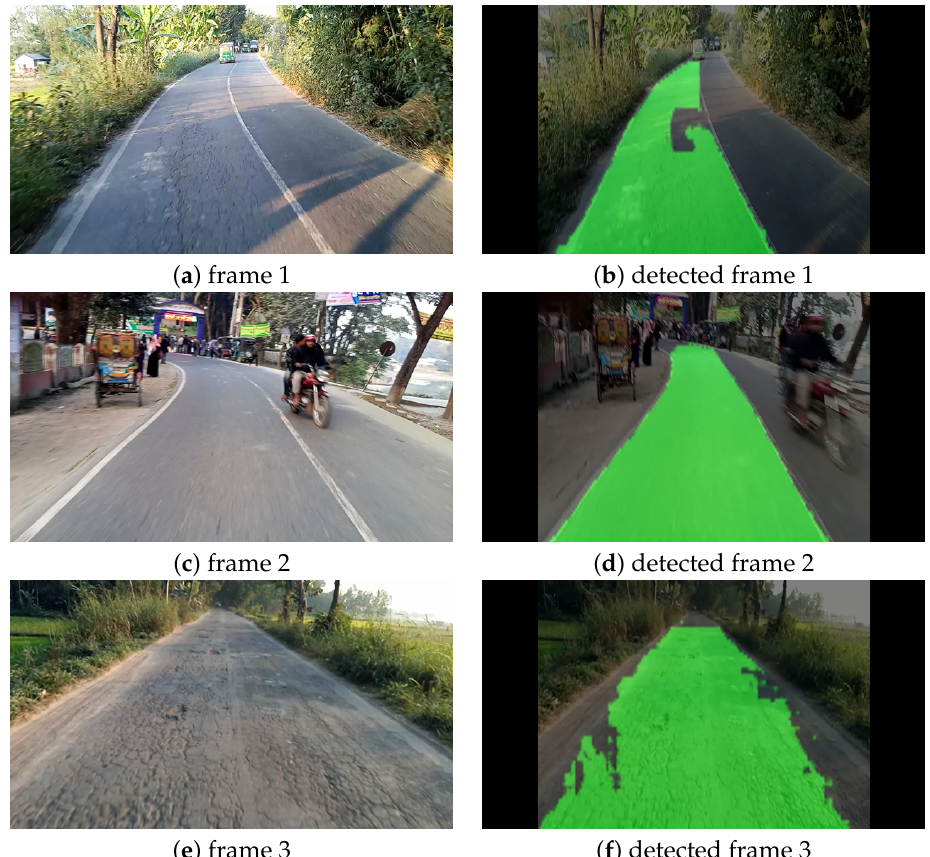
Figure 9. Visualization of lane detection on defected road